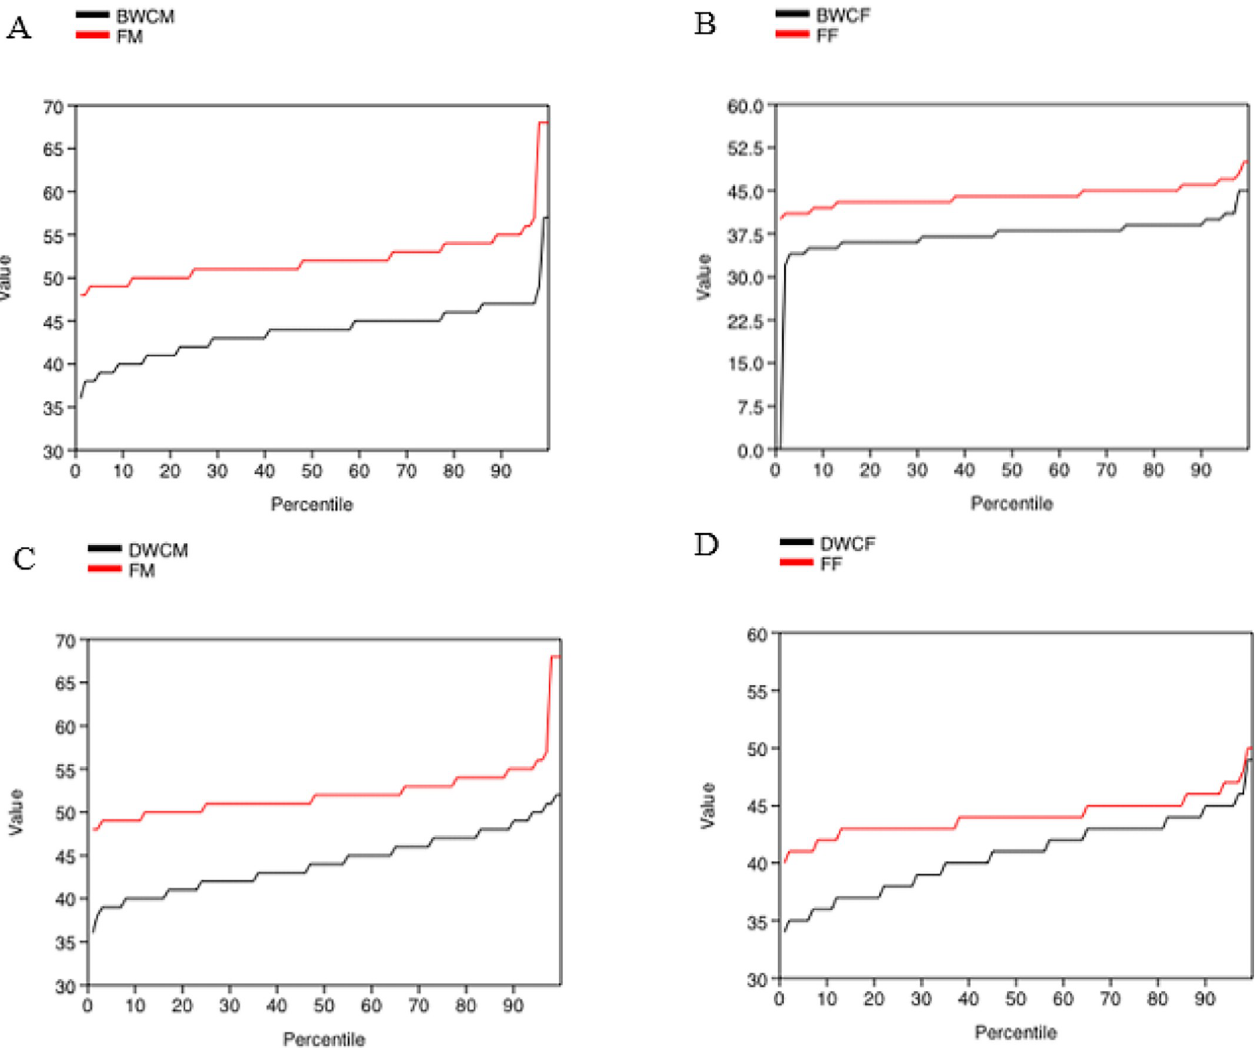
Fig 4. a-d. Cumulative curves of body length of farm mink and mink caught in the wild in Denmark from 2014–2018.